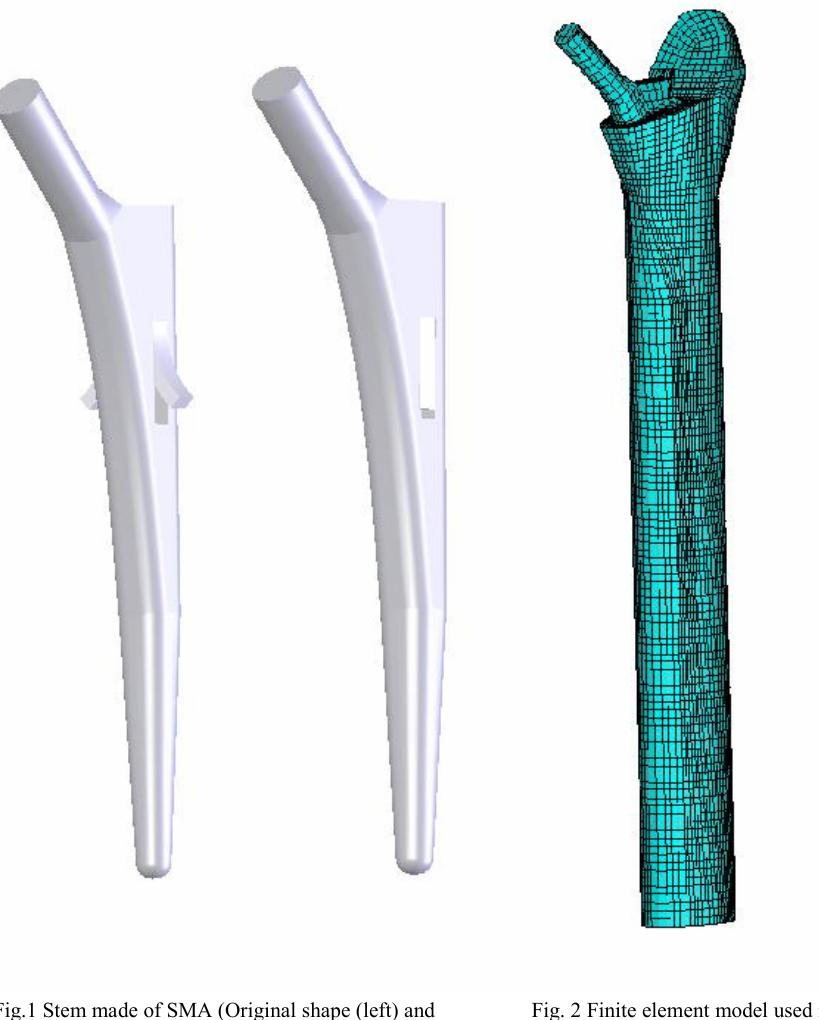
Fig.1 Stem made of SMA (Original shape (left) and deformed shape (right)). One-way shape memory effect was used.